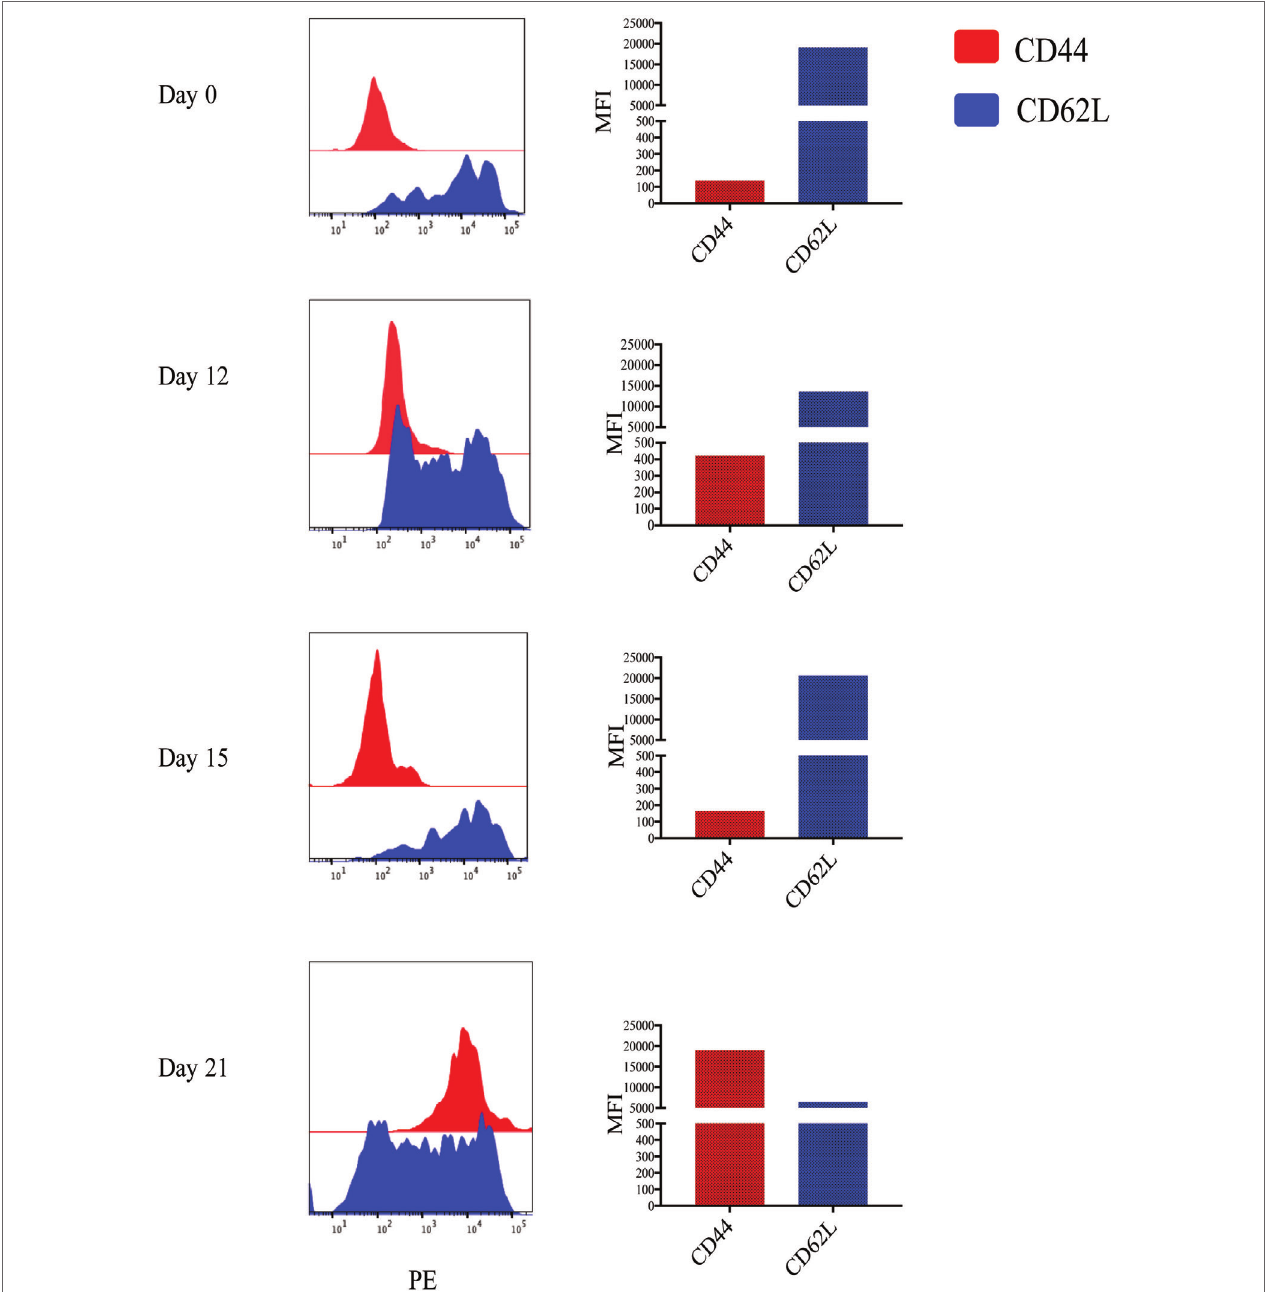
FigUre 2 | Memory markers of Leptospira stimulated cultures. Cultures of peripheral blood mononuclear cells from a vaccinated animal subjected to the T CM and T EM protocol and cells stained for T cell receptor (TCR) δ with monoclonal antibody (mAb) GB21A (FITC) at the times indicated. The TCR δ + cells were flow cytometrically gated on mAb GB21A + and evaluated for their surface marker expression of either CD44 or CD62L (PE) by two-color immunofluorescence shown as histograms. The mean fluorescence intensity (MFI) is shown in the bar